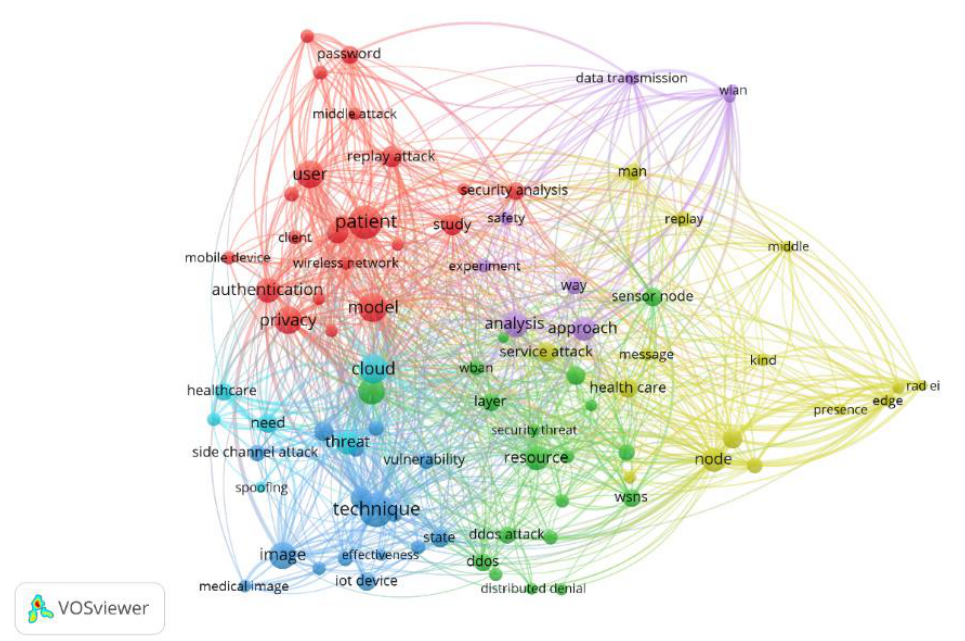
Figure 5. Relevance and occurrence study-full counting.